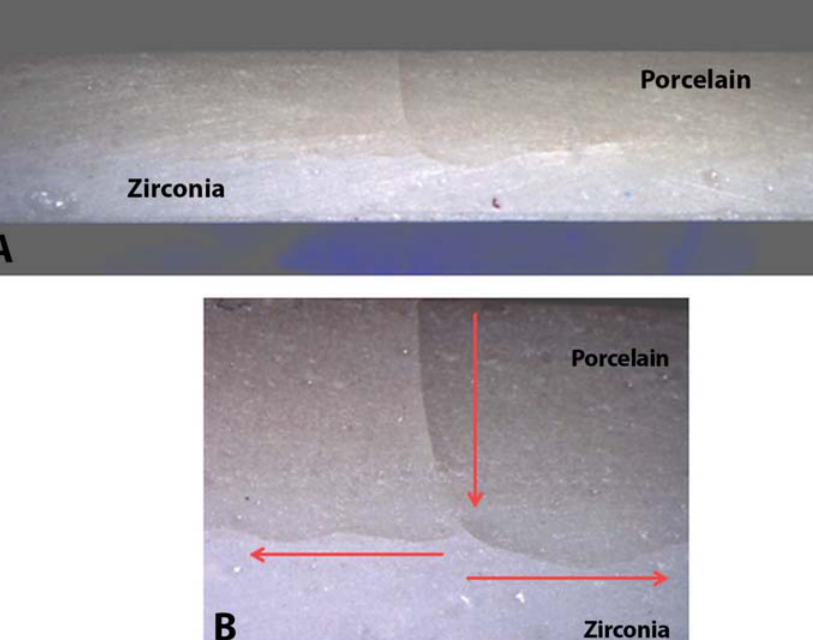
Figure 3- 1-mm-thick porcelain bar. Porcelain cracking (A) (10x). Origin of the crack in the porcelain surface and propagation toward the interface, from center to ends (B) (40x)